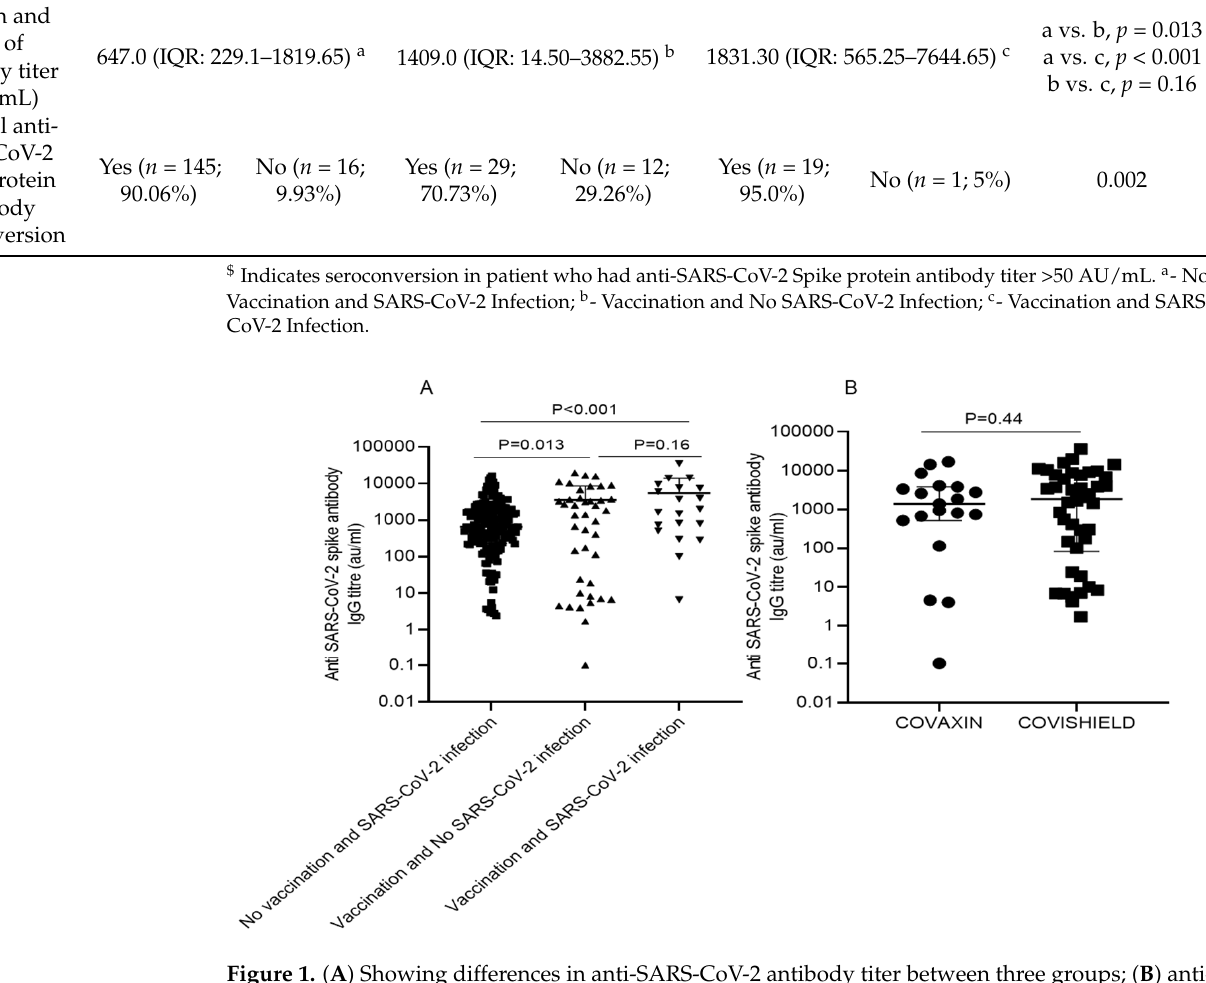
Figure 1. ( A ) Showing differences in anti-SARS-CoV-2 antibody titer between three groups; ( B ) anti- SARS-CoV-2 antibody titer between Covaxin and Covishield. SARS-CoV-2 antibody titer between Covaxin and Covishield. Table 2. Anti-SARS-CoV-2 spike protein antibody titer and seroconversion $ .